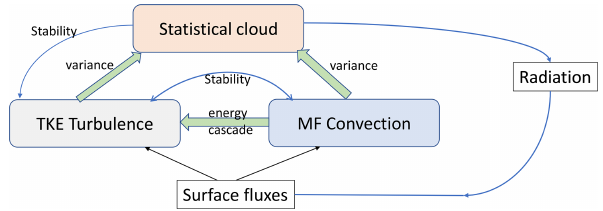
Figure 1. Schematic diagram illustrating the direct (thick ar- rows) and indirect (thin arrows) dependencies of parameterisation schemes with a focus on the schemes involved in the